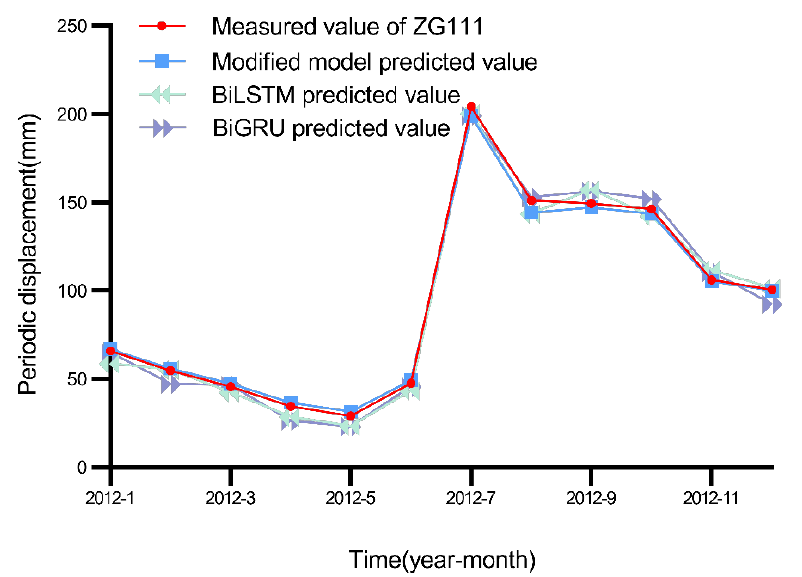
Figure 26. Periodic displacement predicted results of ZG111 using LSTM-FC, BiLSTM and BiGRU models.